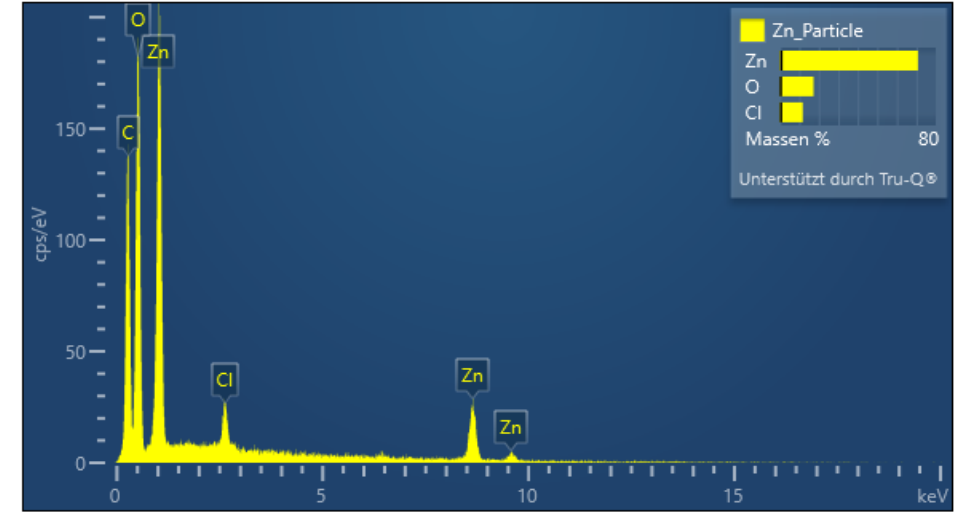
Figure 12. EDS spectra showing the elemental composition of the composite films.